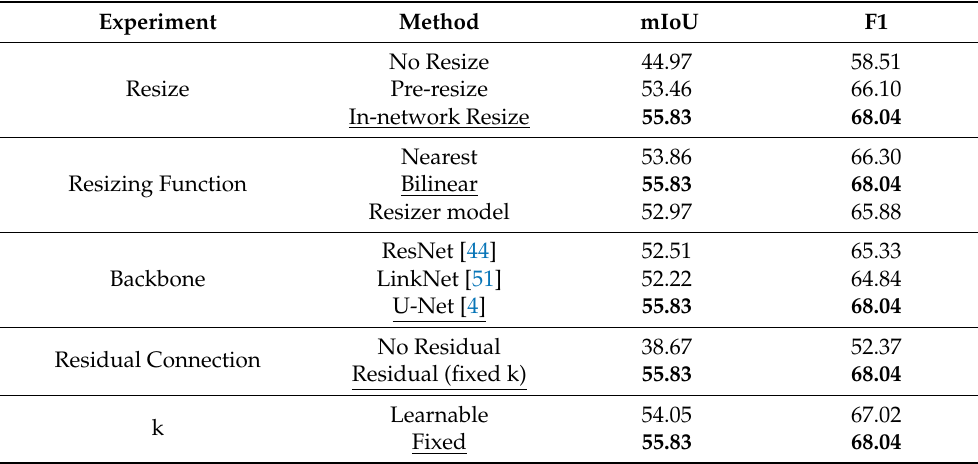
Figure 10. The improvement provided by the resizer module. ( a ) The difference in mIoU between Du- alGAN and ResiDualGAN, which removes the residual connection and DualGAN. ( b ) The difference in mIoU between ResiDualGAN and ResiDualGAN, which removes the resizer module. Table 5. Ablation study for ResiDualGAN. The results are obtained from the task of cross-domain semantic segmentation (from PotsdamIRRG to Vaihingen) and evaluated on the test part of Vaihingen. The mIoU and F1 are overall IoU and overall F1-score,